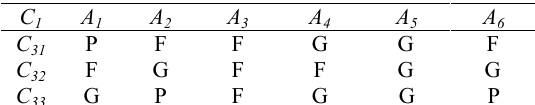
Table 5. Performance assessments of alternatives for Environmental ( C 3 ).